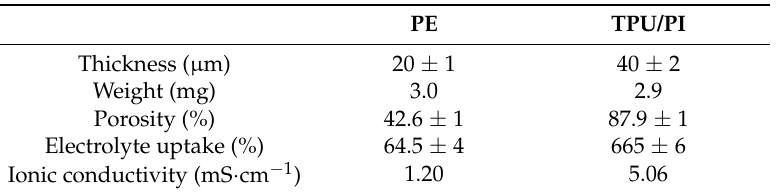
Table 1. Physical properties of the membranes.